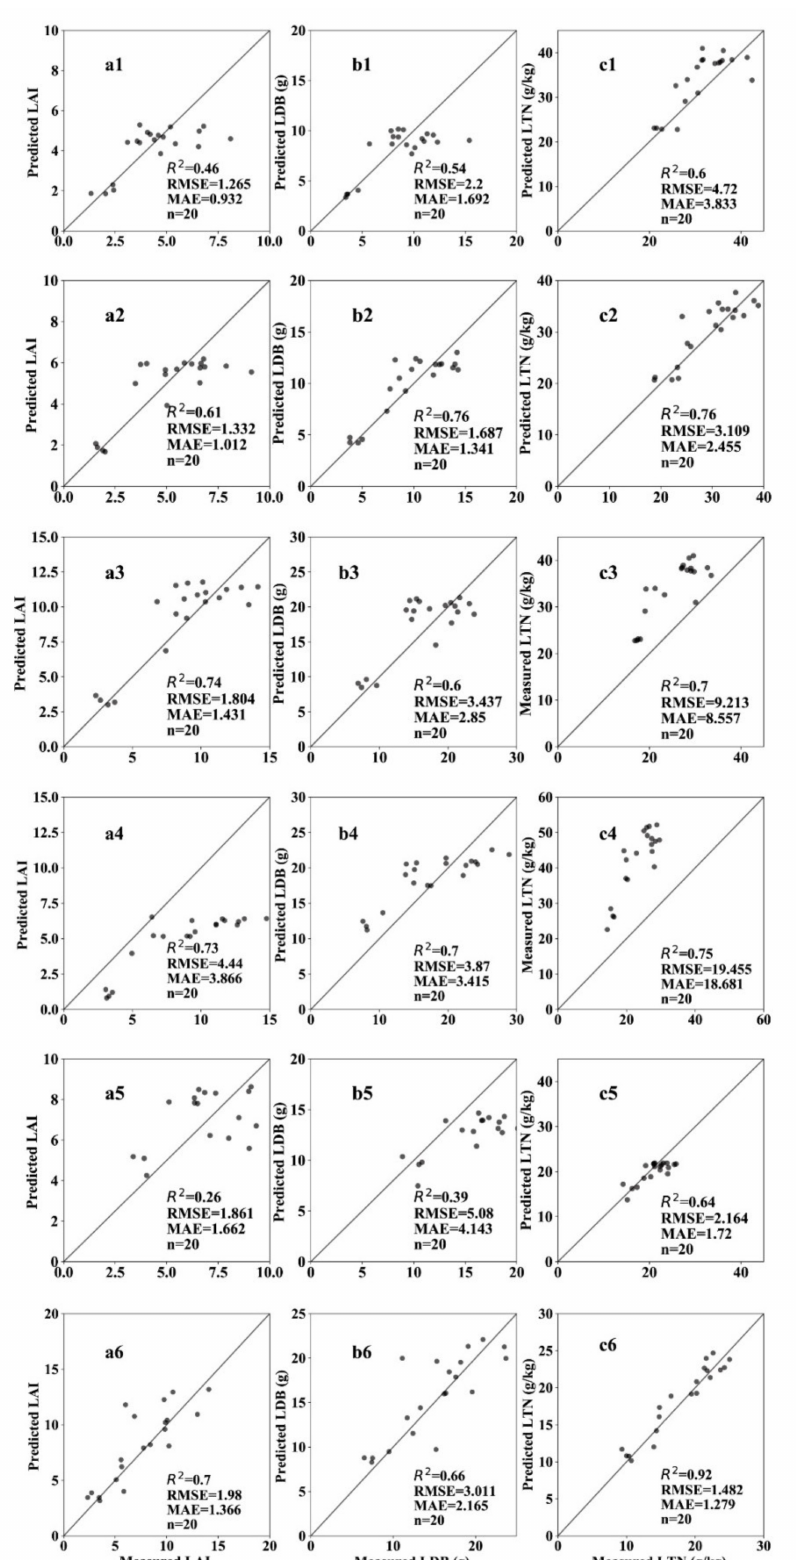
Figure 5. Verification of the estimation results of the key growth indicators at di ff erent growth stages. LAI, LDB, and LTN at the tillering stage ( a1 , b1 , c1 ), early jointing stage ( a2 , b2 , c2 ), late jointing stage ( a3 , b3 , c3 ), heading stage ( a4 , b4 , c4 ), flowering stage ( a5 , b5 , c5 ), and filling stage ( a6 , b6 , c6